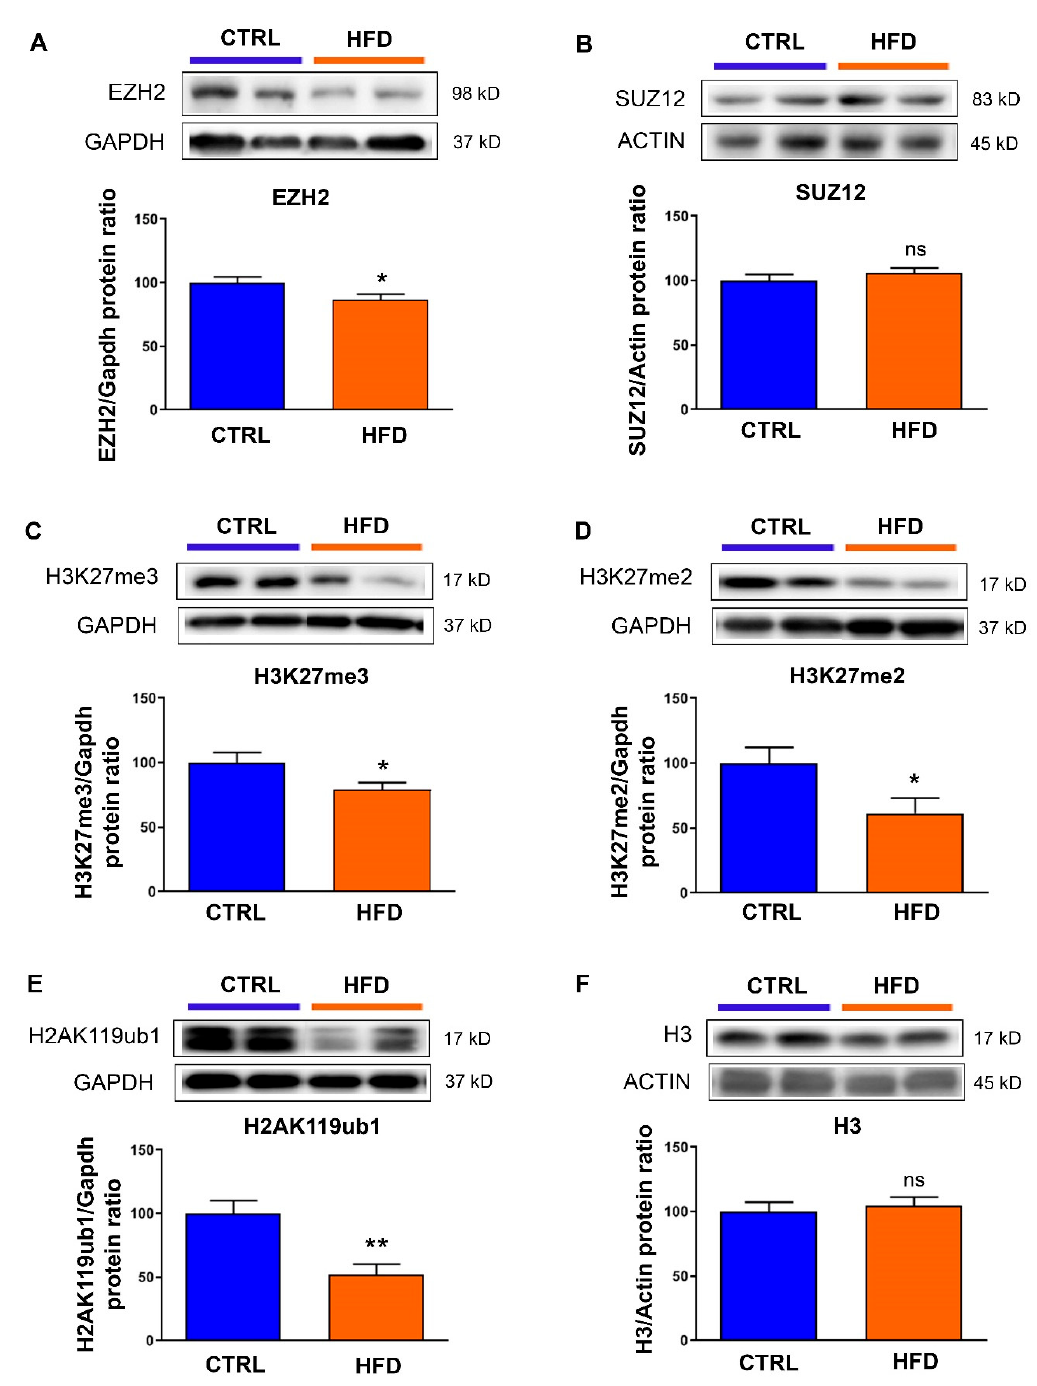
Figure 1. Effects of maternal exposure to high-fat diet on polycomb repressive complex 2 . Protein levels of ( A ) enhancer zeste of homolog 2 (EZH2), ( B ) suppressor of zeste 12 (SUZ12), ( C ) histone H3 trimethyl lysine 27 (H3K27me3), ( D ) histone H3 dimethyl lysine 27 (H3K27me2), ( E ) histone H2A monoubiquitin lysine 119 (H2AK119ub1) and ( F ) histone H3 were analyzed in the heart from male rat at postnatal day 77 under control chow diet (CTRL) or high-fat diet (HFD). Representative immunoblot image is presented for each protein. Data are expressed as the mean ± SEM; n = 13 per group. * p < 0.05, ** p < 0.01 compared to control, ns: not statistically significant.